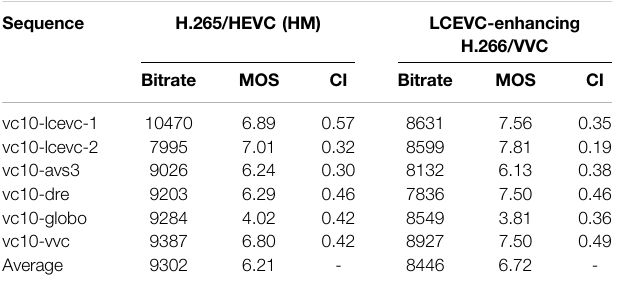
TABLE 8 | Bitrates, MOS scores and CI for HLG sequences. LCEVC and base layer in two separate 6MHz/5Mbps channels.